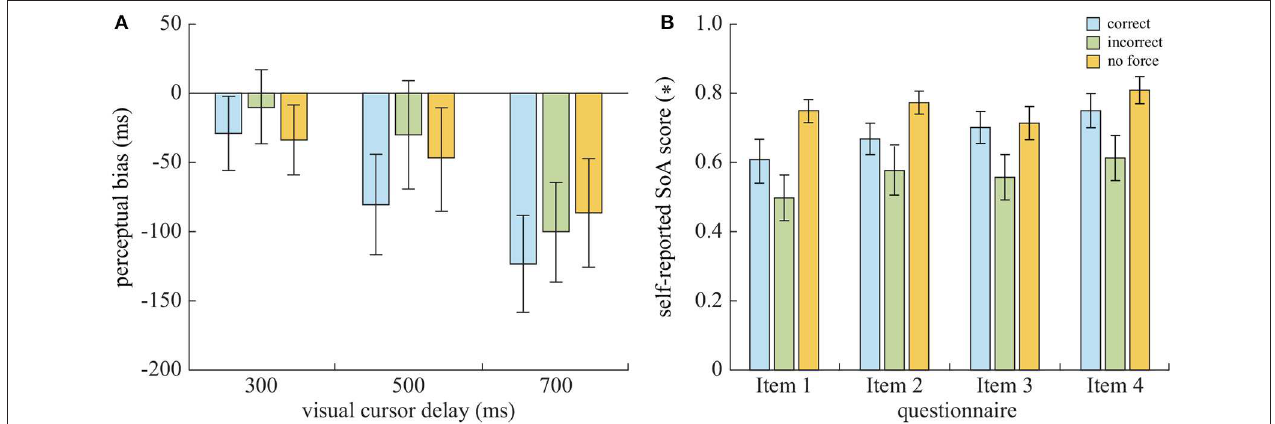
FIGURE 3 | (A) The perceptual bias in the cursor delay estimation. In general, the participants estimated the delay shorter than the actual. (B) The qualitative SoA measured from the four-item questionnaire. The error bars represent one standard error.